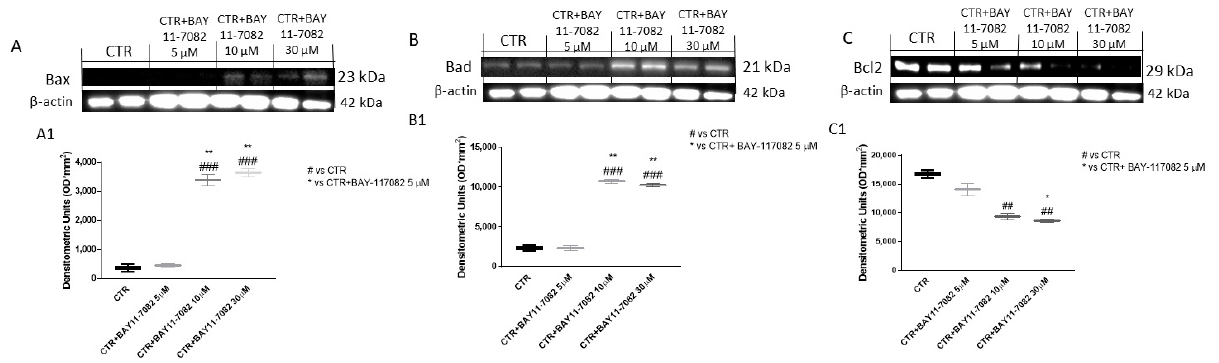
Figure 5. Effect of BAY-117082 on apoptosis pathway. Blots reveal that with BAY-117082 treatment at concentrations of 10 and 30 µM ( A , B ) Bax and Bad expression was increased and ( C ) Bcl2 expression was significantly reduced compared to control group. Data are representative of at least three independent experiments. ( A ) ### p < 0.001 vs. CTR; ** p < 0.01 vs. CTR + BAY-117082 5 µM. ( B ) ### p < 0.001 vs. CTR; ** p < 0.01 vs. CTR + BAY-117082 5 µM. ( C ) ## p < 0.01 vs. CTR; * p < 0.05 vs. CTR + BAY-117082 5 µM.